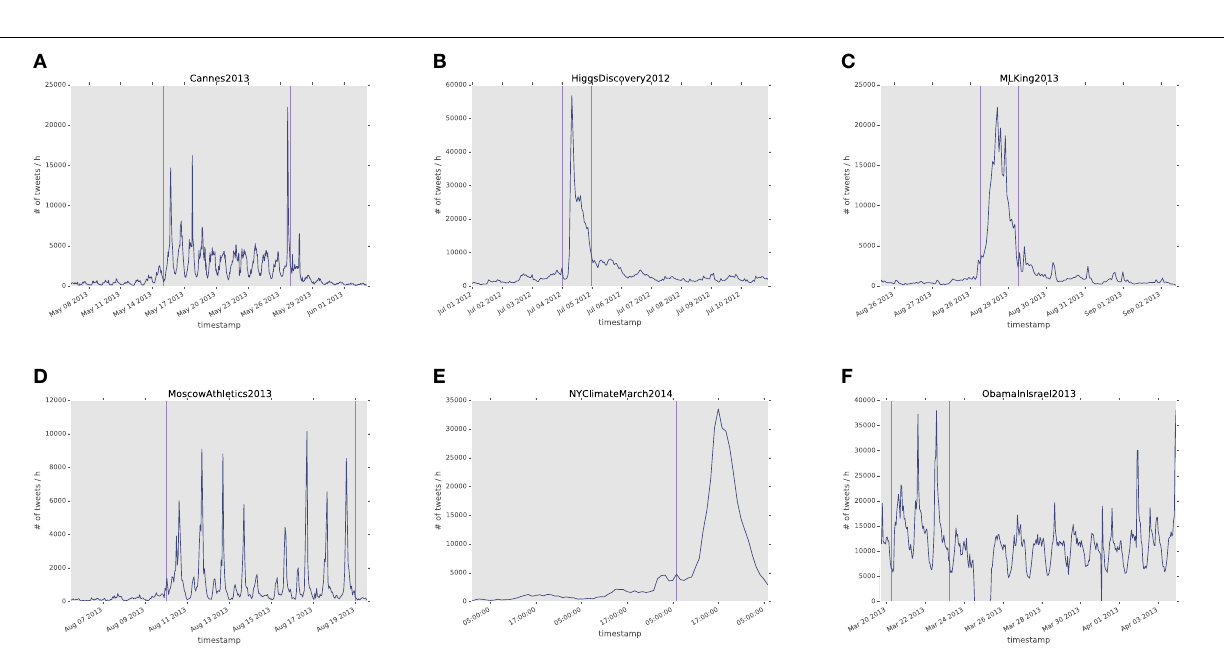
considered in our study presents highly heterogeneous